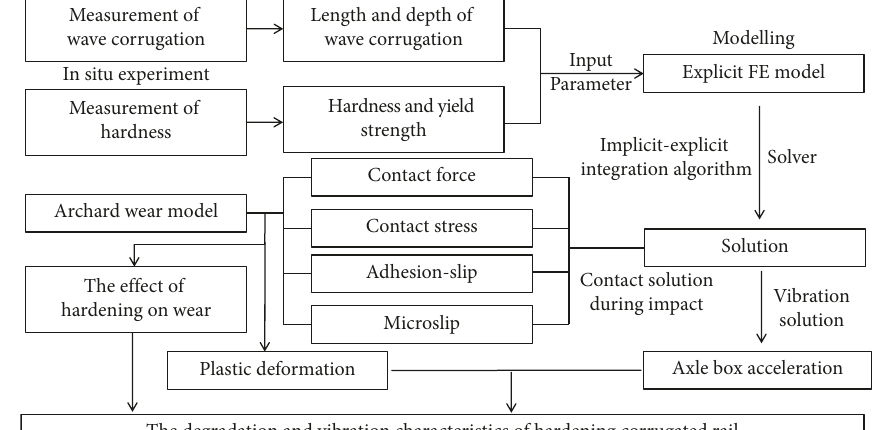
Figure 2: Structure and the schematic